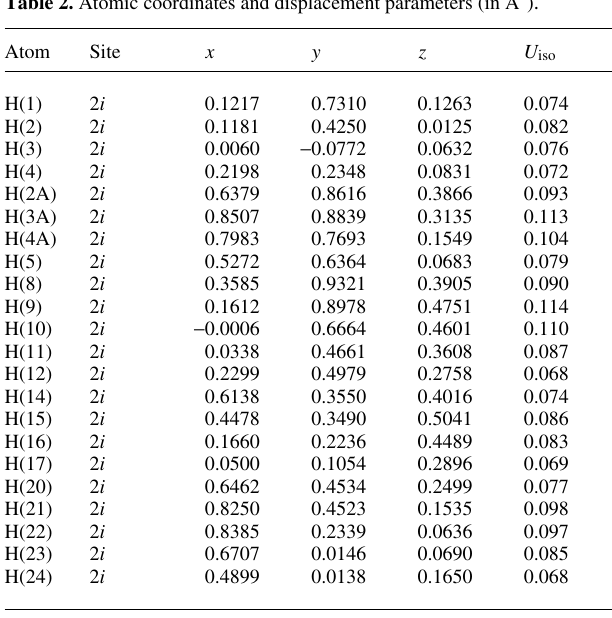
Table 2. Atomic coordinates and displacement parameters (in Å 2 )